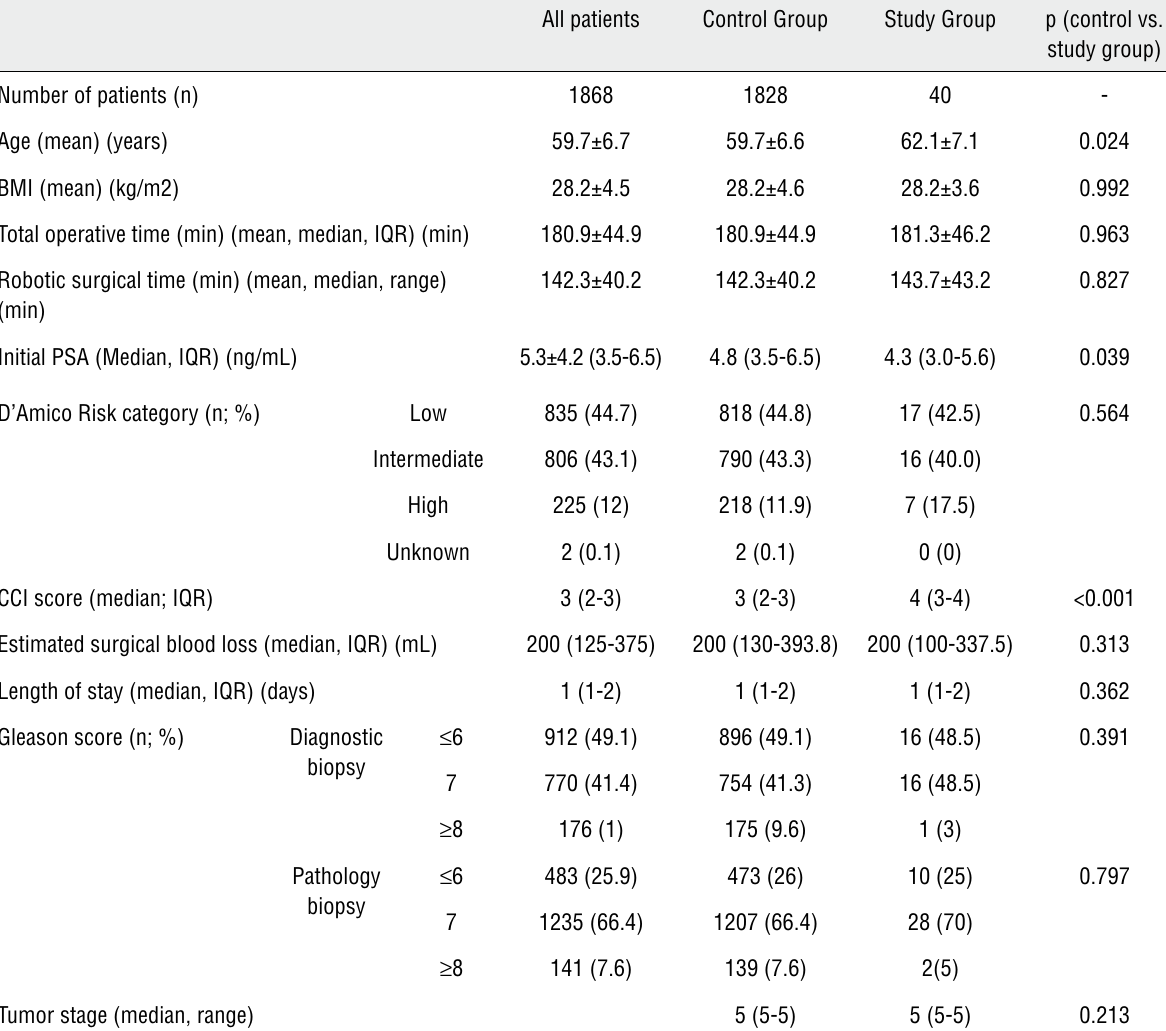
Table 1 - Patient demographics and clinical data of patients who underwent